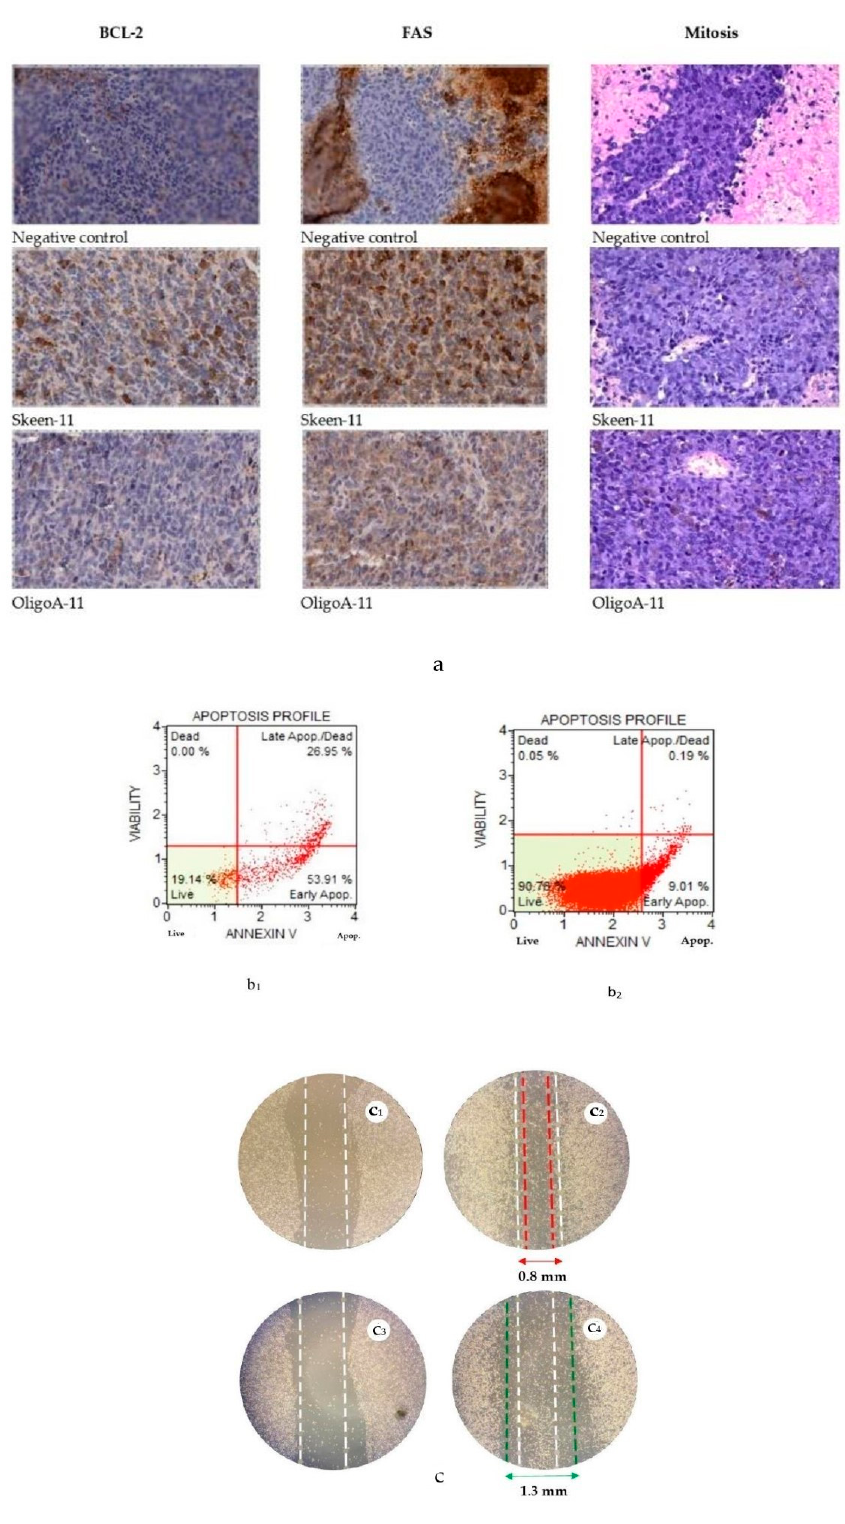
Figure 2. ( a ) Histological sections of melanoma tumors in different groups of the experiment (control, Skeen-11, OligoA-11) (magnification 400 × ). ( b ) Apoptosis profile of melanoma cells from different groups, stained with Annexin V and Dead Cell 12 h after exposure to: ( b 1 )—Skeen–11; ( b 2